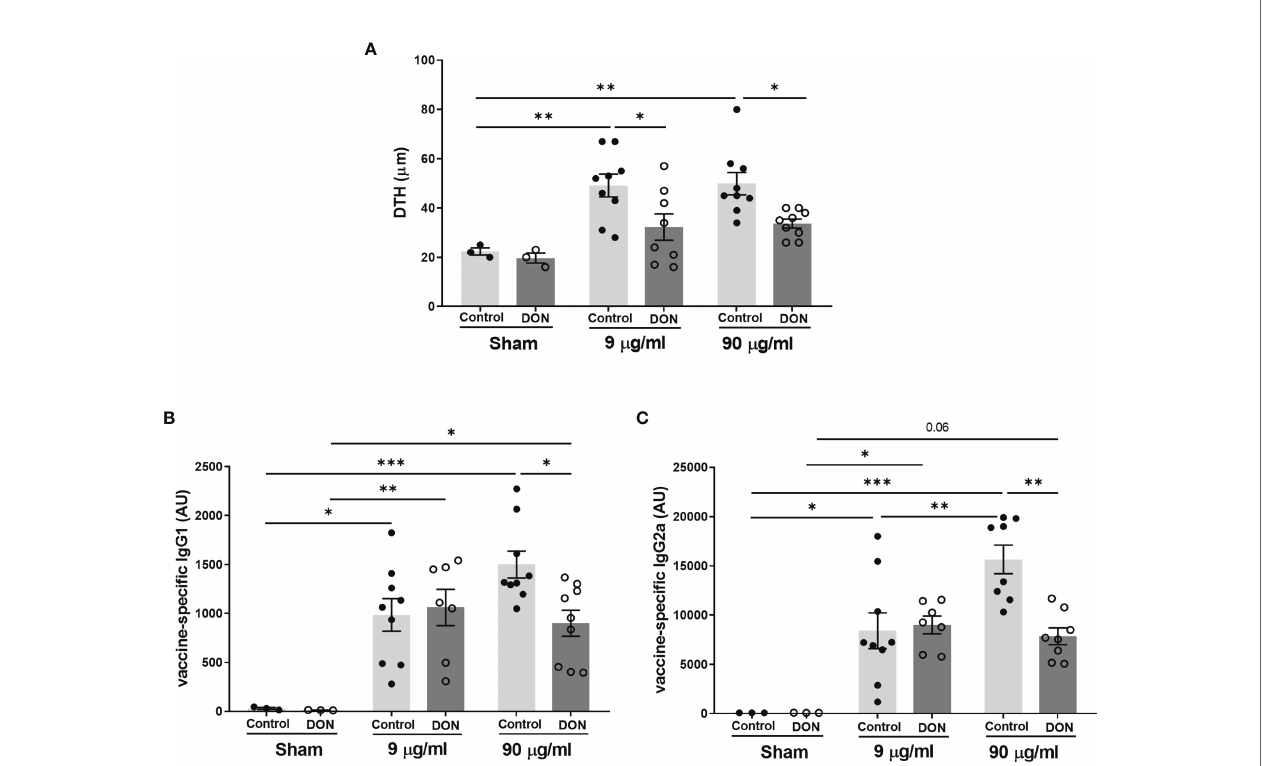
FIGURE 3 | Maternal deoxynivalenol (DON) exposure reduced vaccine-speci fi c immune responses in the male offspring. Pregnant mice fed either a control or DON- contaminated diet (12.5 mg/kg) during pregnancy and lactation period. Male offspring received subcutaneous injections of either phosphate-buffered saline (PBS, sham) or In fl uvac (9 and 90 µg/mL) after weaning. 10 days after the second injection, (A) vaccine antigen-speci fi c delayed-type hypersensitivity (DTH) was measured as changes in ear thickness 24 hours after intradermal challenge in In fl uvac; and (B) vaccine antigen-speci fi c immunoglobulin (Ig)G1 and (C) IgG2a levels were measured in serum. Data are presented as mean ± SEM. *p < 0.05, **p < 0.01 and ***p < 0.001 indicate statistical